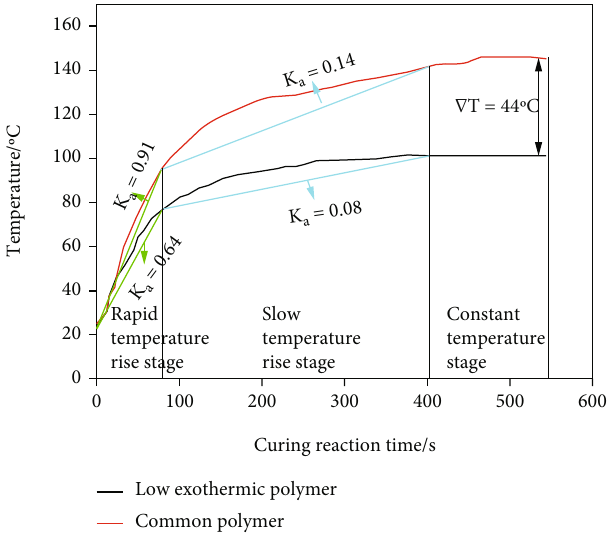
Figure 11: Temperature curve during curing